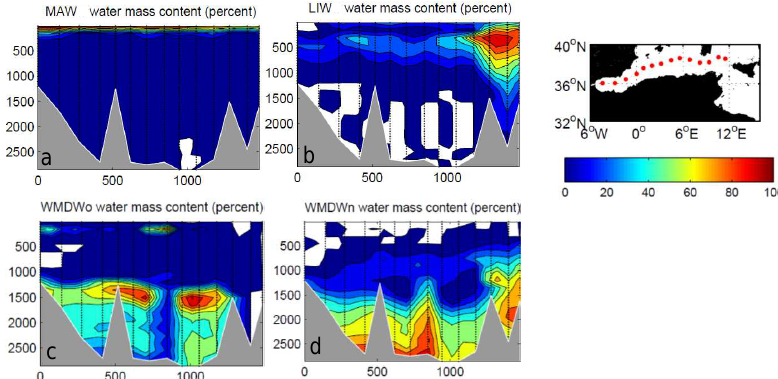
Figure 7. Water mass fractions in percent for the western Mediterranean Sea. Panels (a, b) show Modified Atlantic Water and Levantine Intermediate Water for the OMP case AW–LIW–WMDW n . Panel (c) shows old Western Mediterranean Deep Water for the case AW– WMDW n –WMDW o and panel (d) shows new Western Mediterranean Deep Water for the case LIW–WMDW n –WMDW o . The y axes indicate depth in dbar and x axes specify distance in km. The right panel shows the location of considered stations. White patches are areas for which the OMP method is not valid.